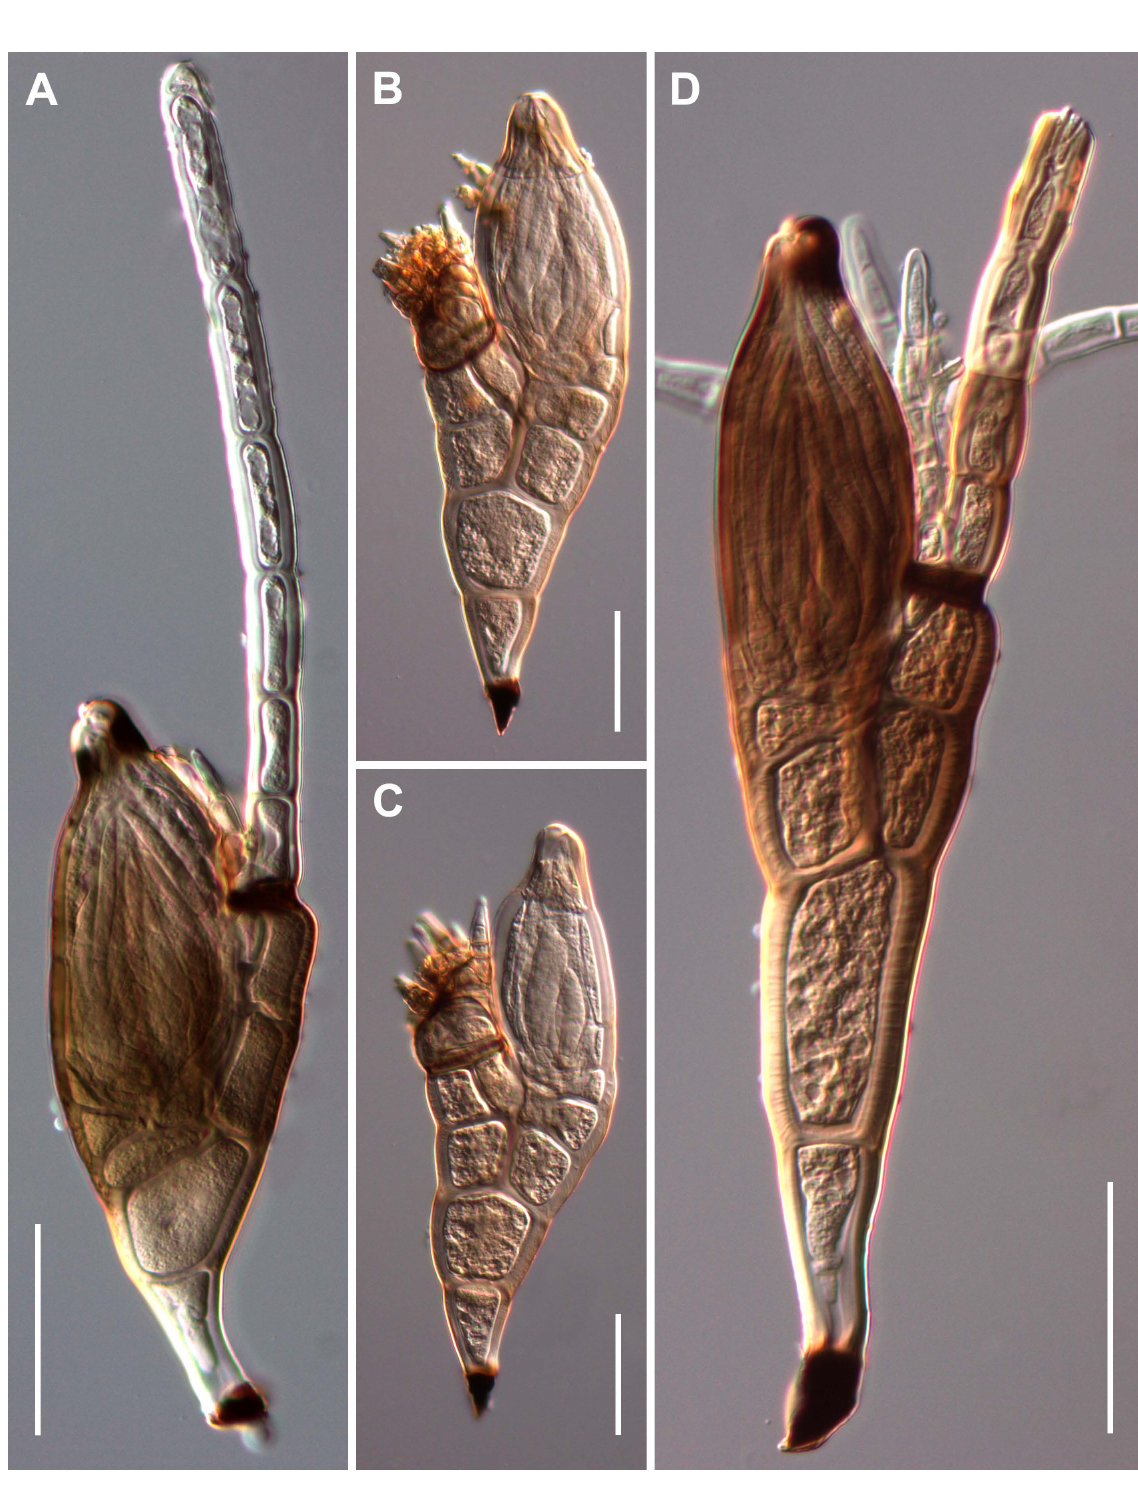
Fig. 26. Laboulbenia spp. A . L. benjaminii Balazuc ex Santam. Mature thallus. – B – C . L. cafii Thaxt. B . Mature thallus. C . Submature thallus. – D . L. calathi . Mature thallus. Scale bars: 50 µm. Photographs from slides ZMUC C-F-122487 (A), ZMUC C-F-124213 (B–C), ZMUC C-F-122526